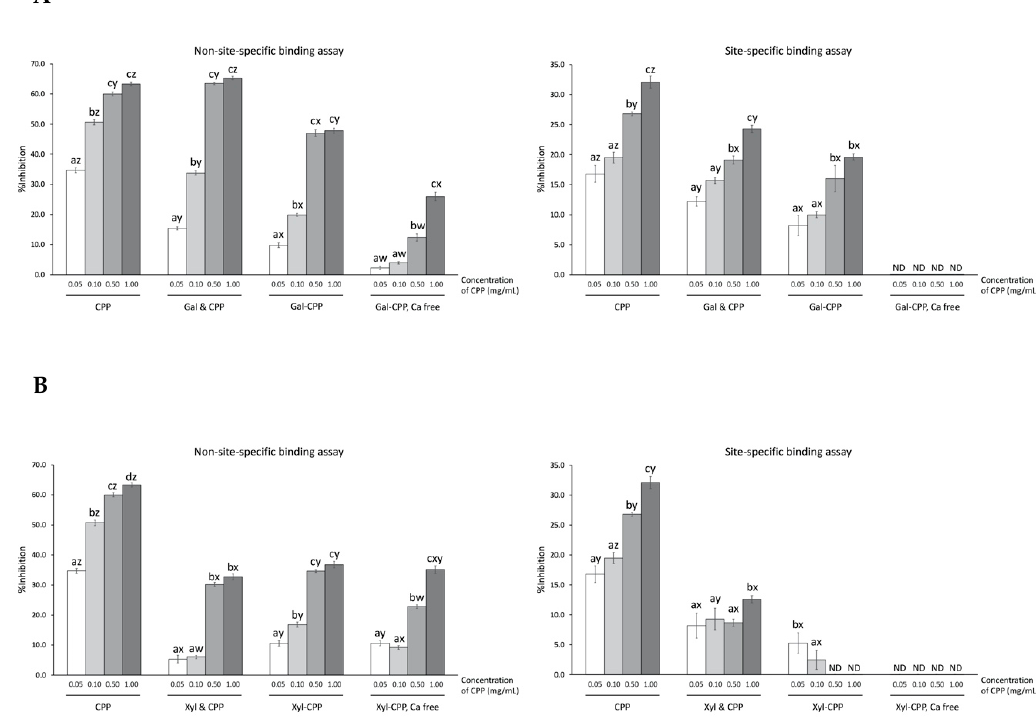
Figure 3. Inhibition of Fenton reaction-induced deoxyribose oxidation via non-site-specific and site-specific binding by CPP and CPP–polysaccharide (( A ) Gal; and ( B ) Xyl) conjugates and mixtures. Non-site-specific binding assay: ascorbic acid-mediated Fenton reaction in the presence of EDTA; site-specific binding assay: ascorbic acid-mediated Fenton reaction in the absence of EDTA. CPP, casein phosphopeptide; Gal (or Xyl) & CPP, non-conjugated mixtures of galactomannan (or xyloglucan) and CPP; Gal–CPP or Xyl–CPP, conjugates of galactomannan or xyloglucan with CPP formed by employing Maillard reaction conditions; ND, not detectable ( < 0.1% inhibition). All detectable results are expressed as mean ± SD ( n = 3) and were statistically analyzed by one-way ANOVA and Tukey’s post-hoc test. Letters (a–d) denote significantly di ff erent means within the same treatment group in an assay, indicating e ff ects of CPP concentration; letters (w–z) denote significantly di ff erent means with the same CPP concentration level in an assay, indicating e ff ects of treatment ( p < 0.01).